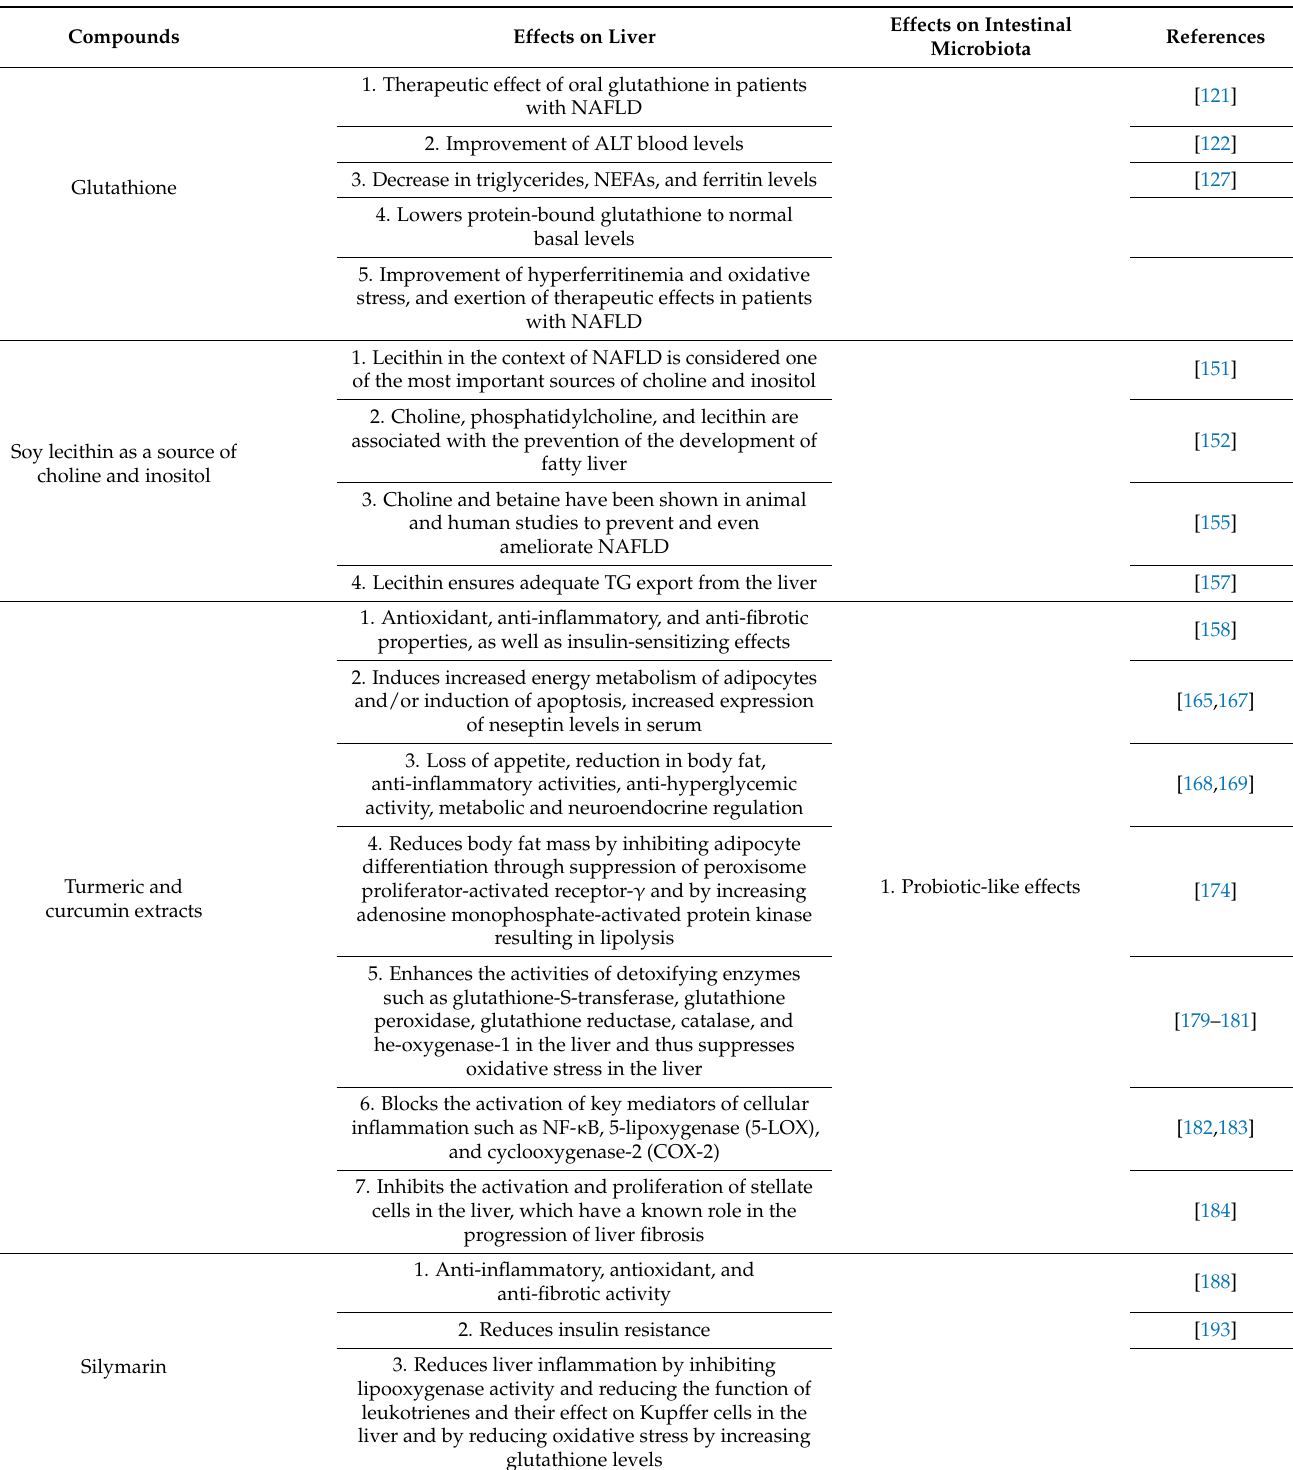
Table 2. General and nutritional-associated compounds with beneficiary action on